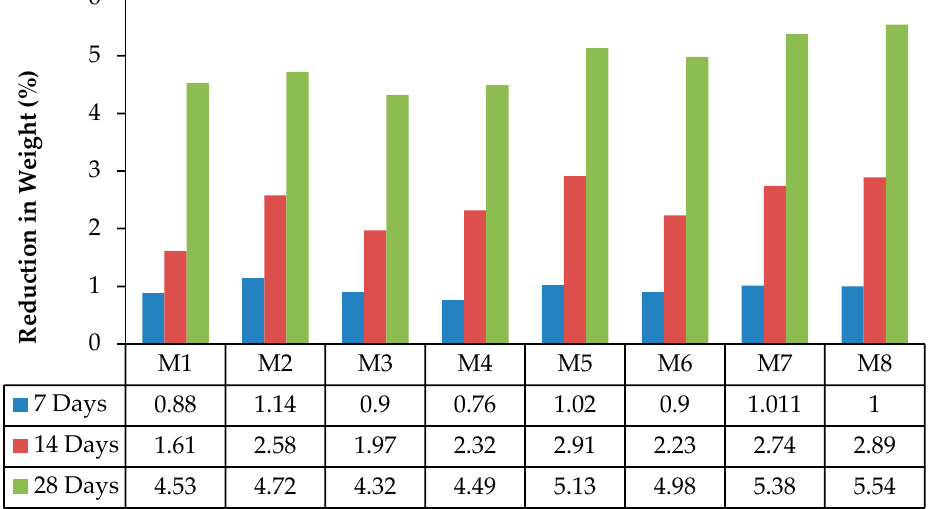
Figure 9. Acid test results of blended cement paste.